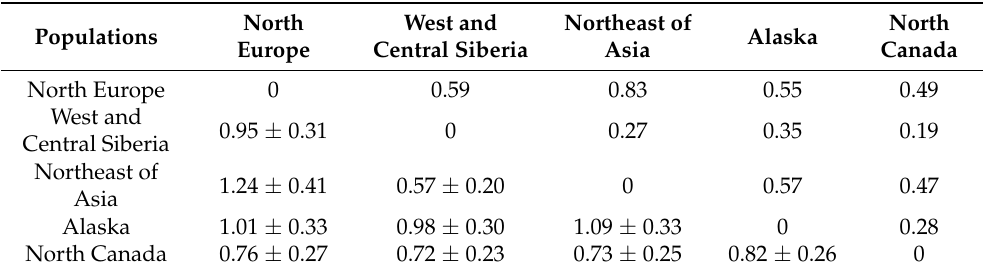
Table 1. Mean genetic divergences between population groups of Pterostichus brevicornis brevicornis (COI uncorrected p-distance ± standard error estimations, %) on the lower diagonal and F ST values on the upper diagonal (significance of all measures p < 0.0001).